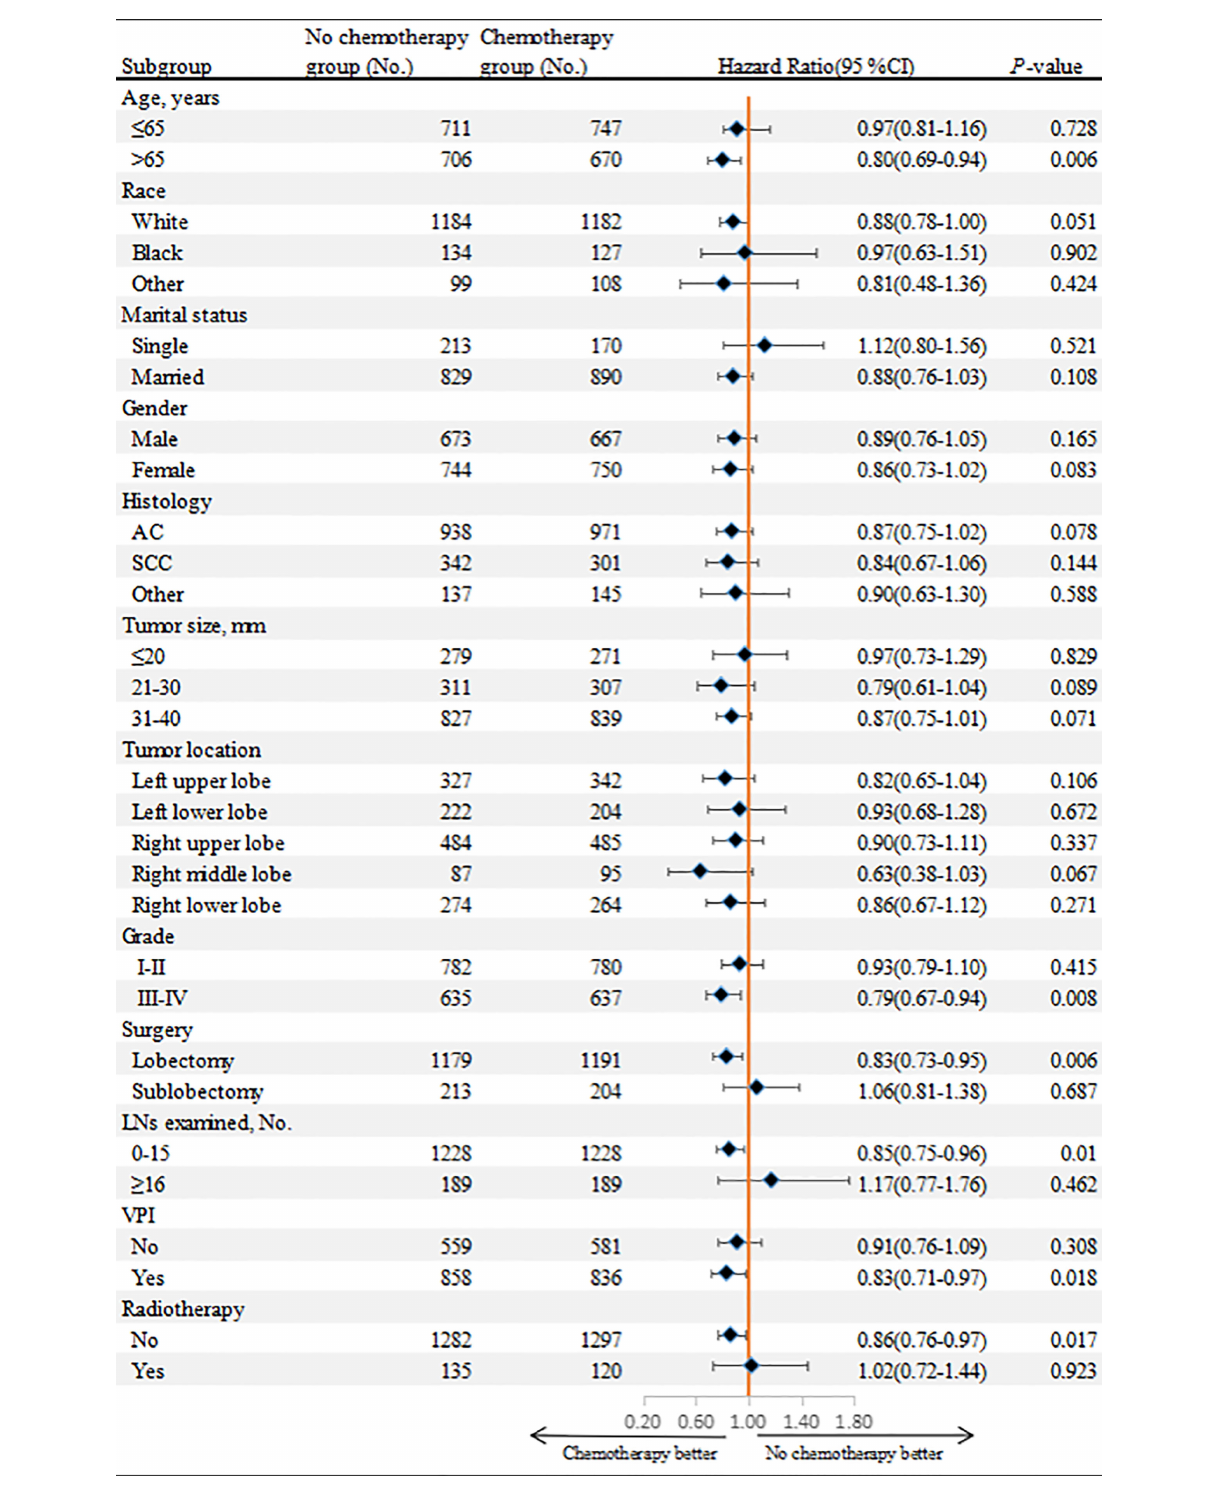
Frontiers in Oncology |